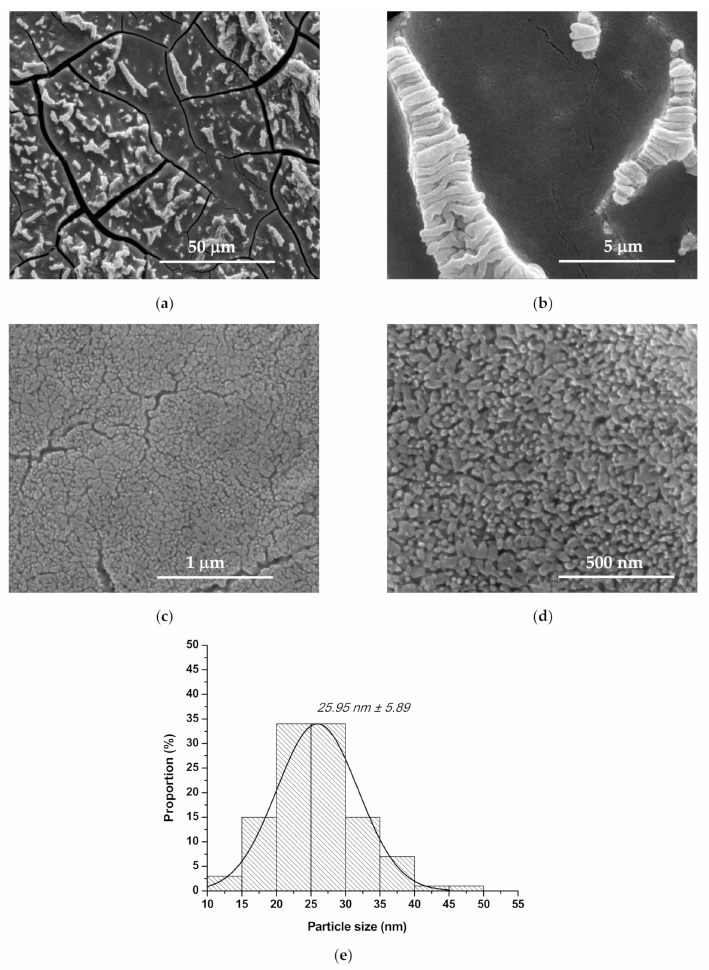
Figure 3. Scanning electron microscope (SEM) images ( a – d ) and grain size distribution ( e ) for ZnO